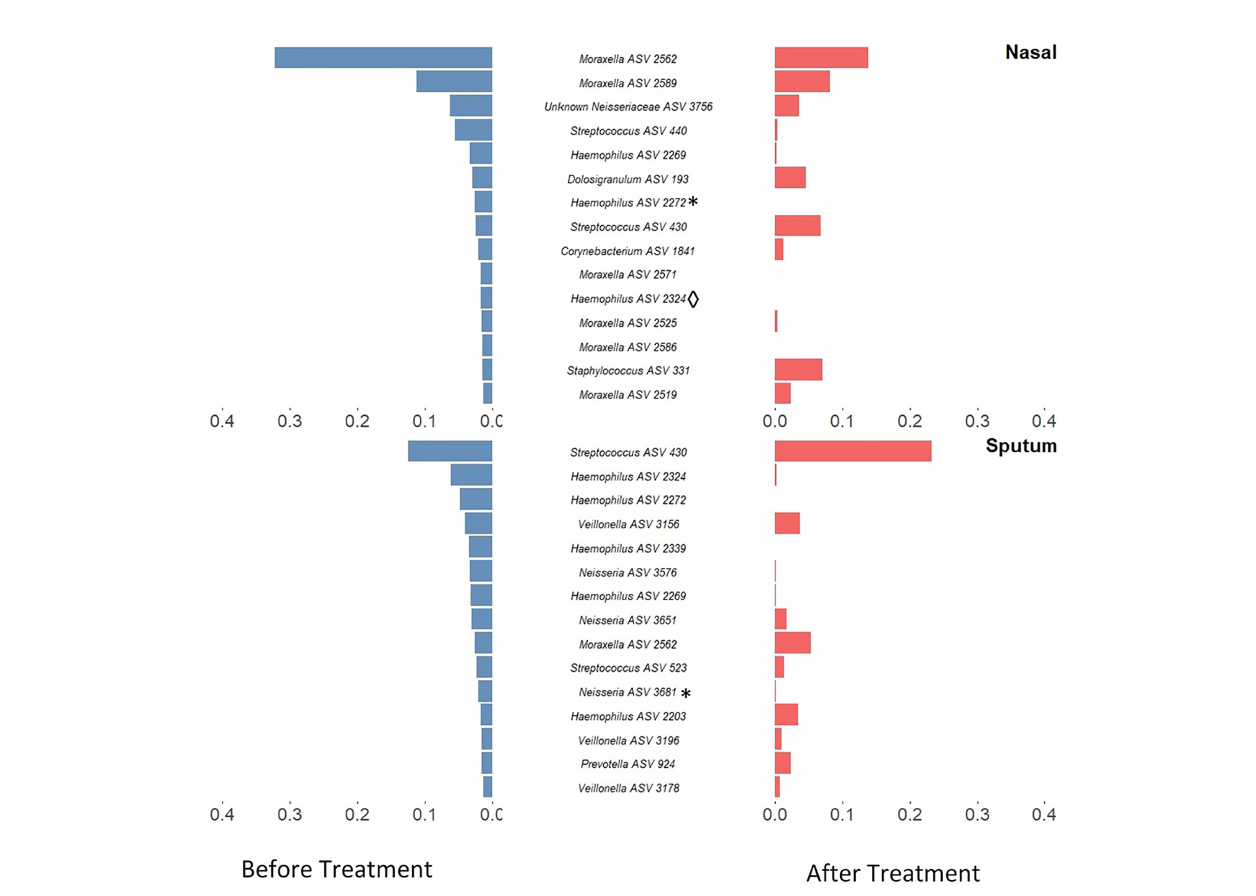
FIGURE 2 | Rank-abundance plots showing the 15 most abundant 16S rRNA gene ASVs in paired samples from before treatment (blue) and their respective abundance after treatment (red). ASVs are ranked based on their relative sequence abundance before treatment. Taxonomic composition was altered in both sputum and nasal samples with a notable decrease of Haemophilus ASVs in sputum samples and Moraxella in nasal samples. Those ASVs which were identi fi ed as signi fi cantly differentially abundant by DESeq2 are marked by * while those which were identi fi ed as signi fi cantly differentially abundant by LEfSE are denoted by ◊ . An inverse version of this plot, whereby ASVs are ranked based on their relative sequence abundance after treatment, can be found in Figure S3